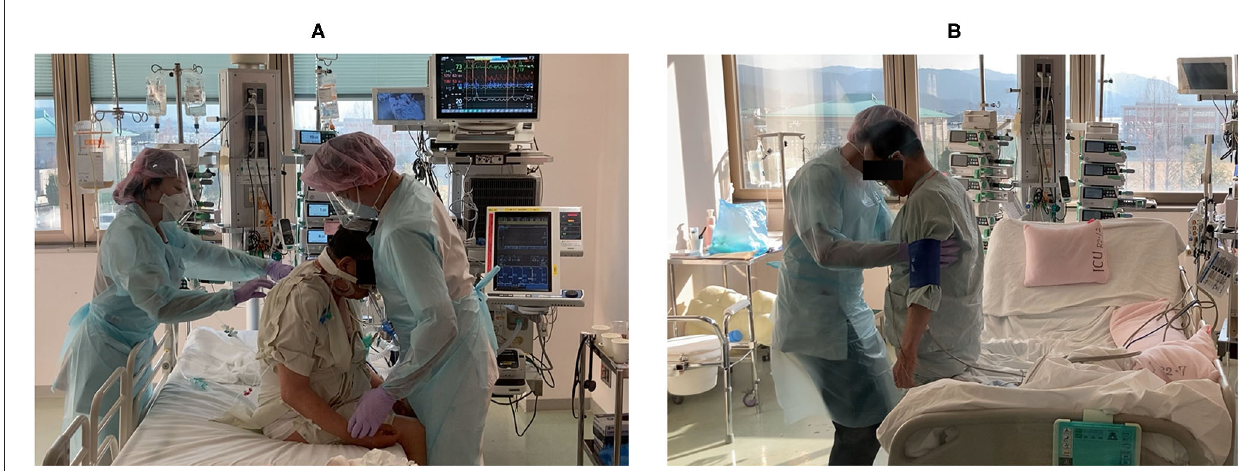
FIGURE 3 | A representative rehabilitation scene. The patient (A) sitting on the edge of the bed at the beginning of rehabilitation (day 3) and (B) performing half-squats and calf-raises before regional hospital transfer (day 18).